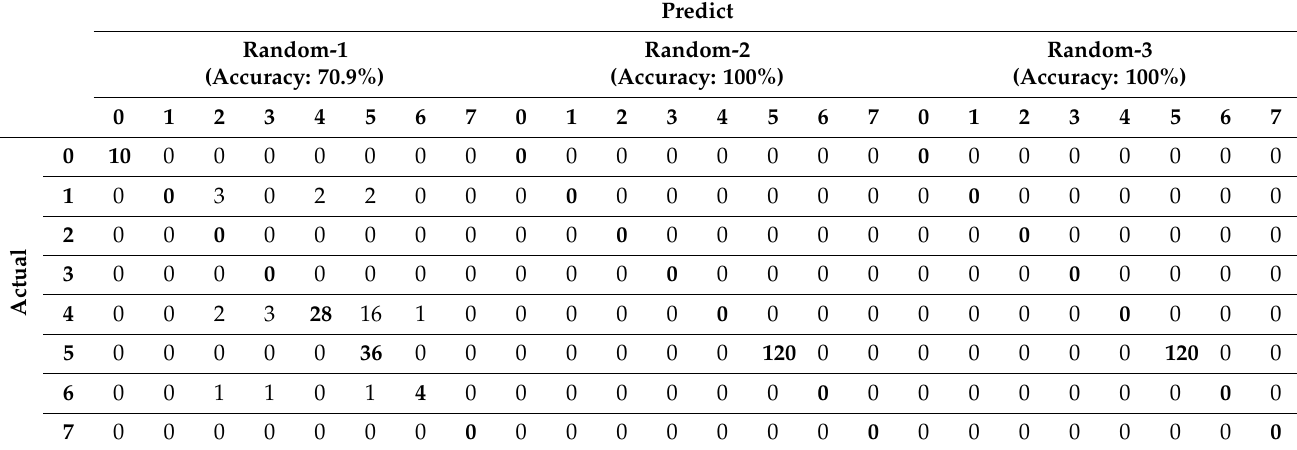
Table 8. Confusion matrix for Room 1 Sequence 8 (with median